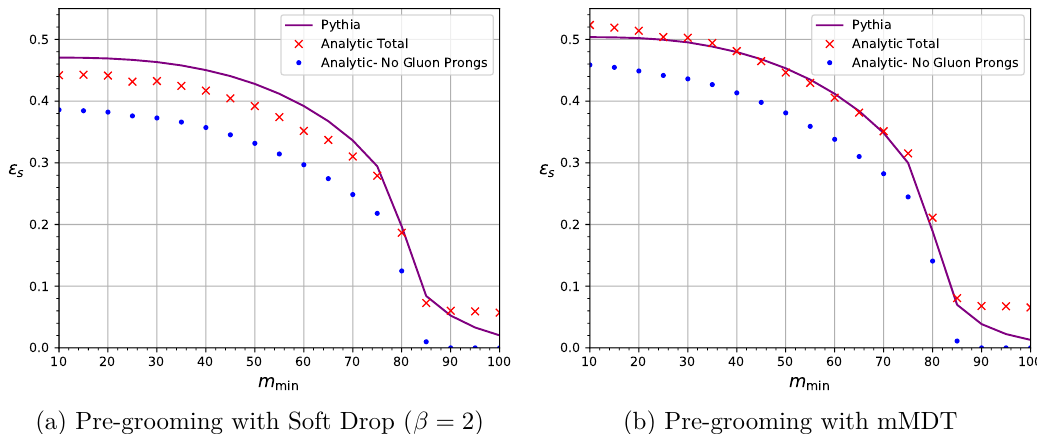
Figure 7. A comparison between our analytical calculations and a Pythia simulation for pre- groomed top jets tagged with Y m -Splitter in a mass range 163 GeV < m < 225 GeV with ζ = 0 . 05 as a function of m min